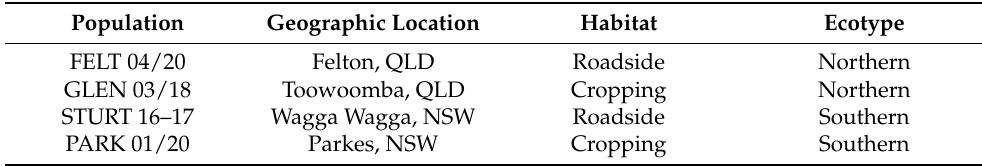
Table 1. Four populations used in the phenology study of feathertop Rhodes grass. Population Geographic Location